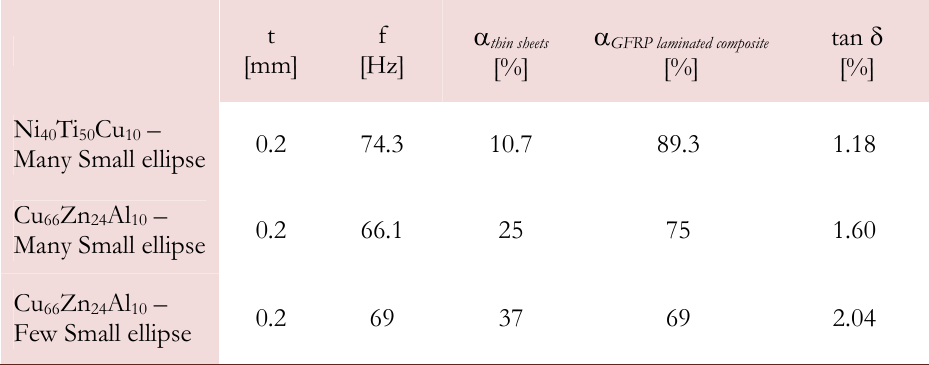
Table 4: FEM analysis estimated loss factor of the hybrid composite, comparison between Ni 40 Ti 50 Cu 10 and Cu 66 Zn 24 Al 10 thin sheets